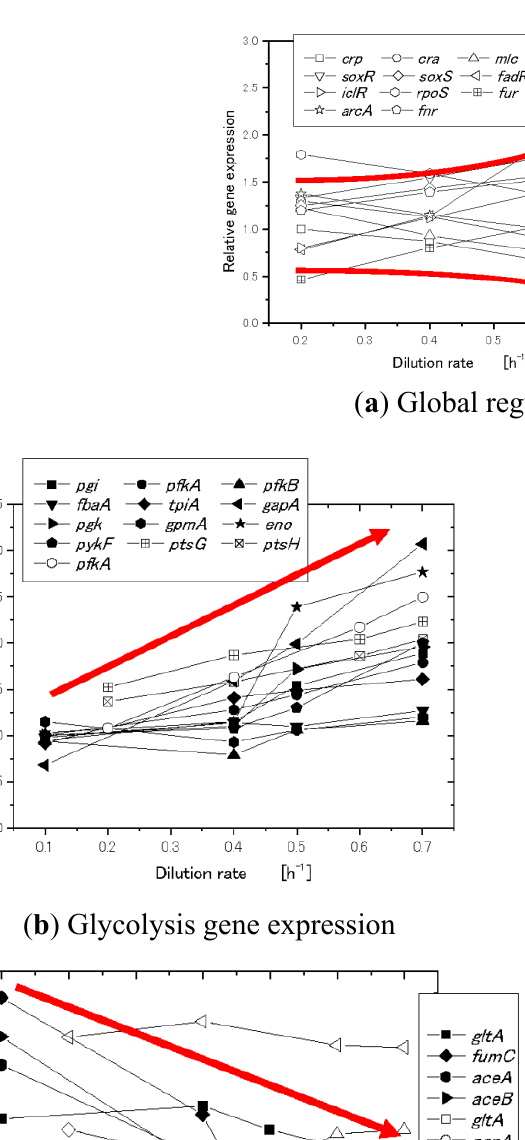
Figure 4. Effect of the growth rate (dilution rate in the continuous culture) on gene expression and fluxes: ( a ) global regulators, ( b ) glycolysis genes, ( c ) TCA cycle genes, ( d ) PP pathway genes, and ( e ) TCA cycle fluxes and acetate formation rate. Open symbol from [47], while filled symbol from